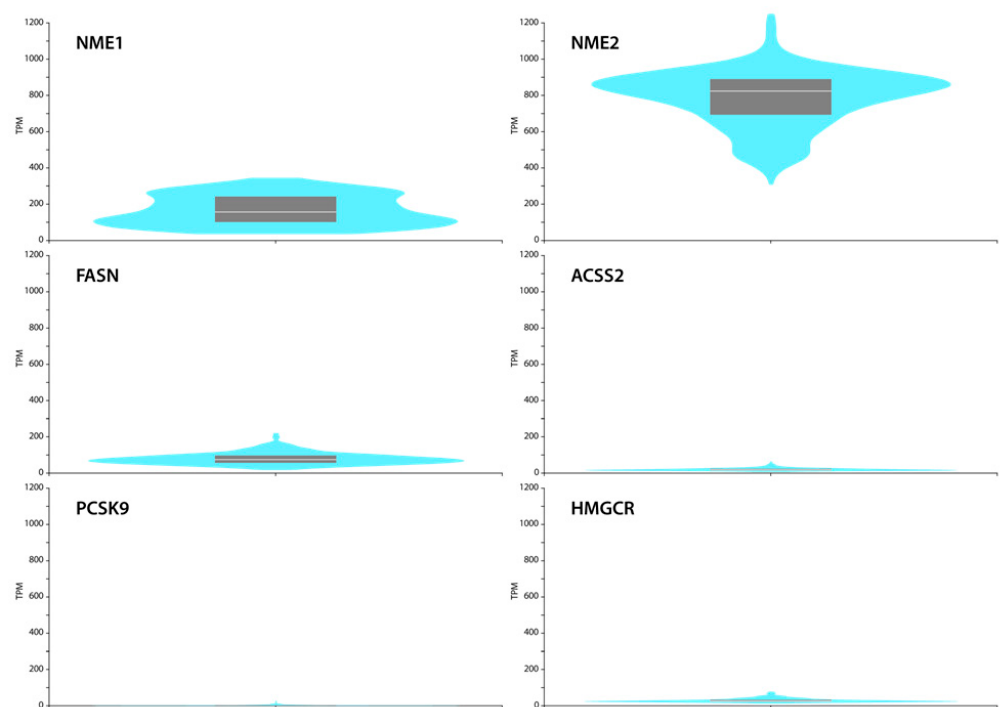
Figure 7. GTEx Portal (a reference website) data show mRNA expression of NME1, NME2, FASN, ACSS2, PCSK9, HMGCR in cultured skin fibroblasts. Box plots are shown as median and 25th and 75th percentiles; points are displayed as outliers if they are above or below 1.5 times the interquartile range. Expression values are shown in TPM (transcripts per million) in a linear representation.